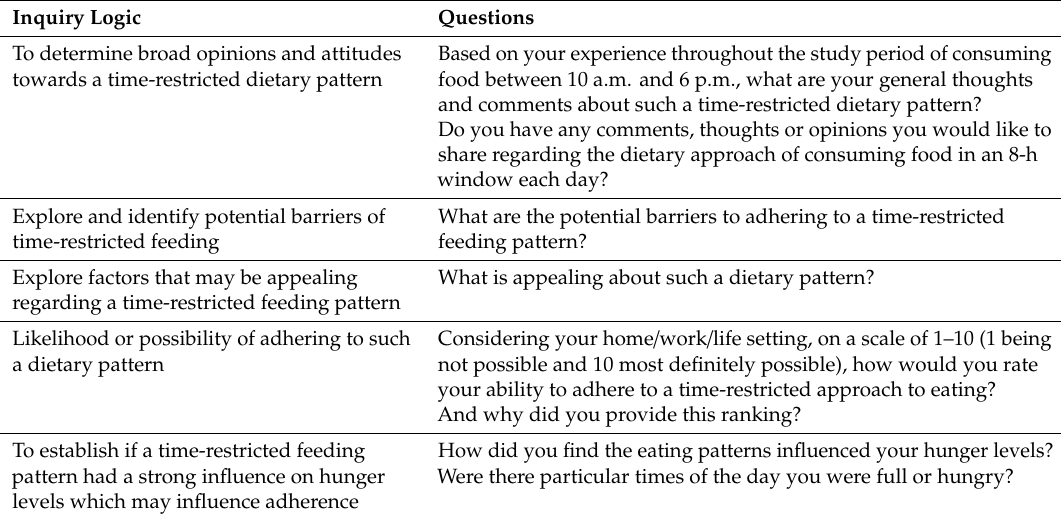
Table 2. Semi-structured interview questions and inquiry